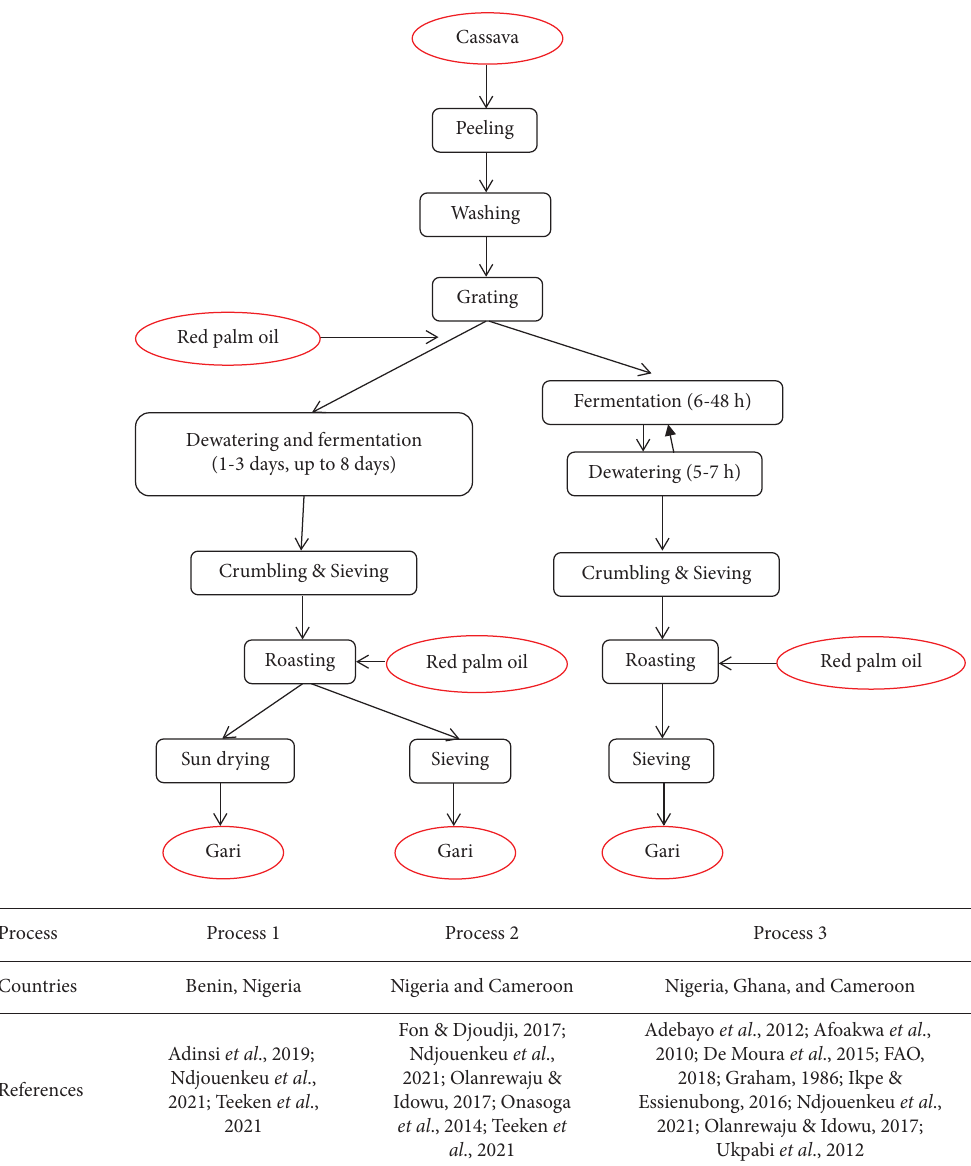
Figure 2: Processes used for the production of Gari from cassava in some SSA